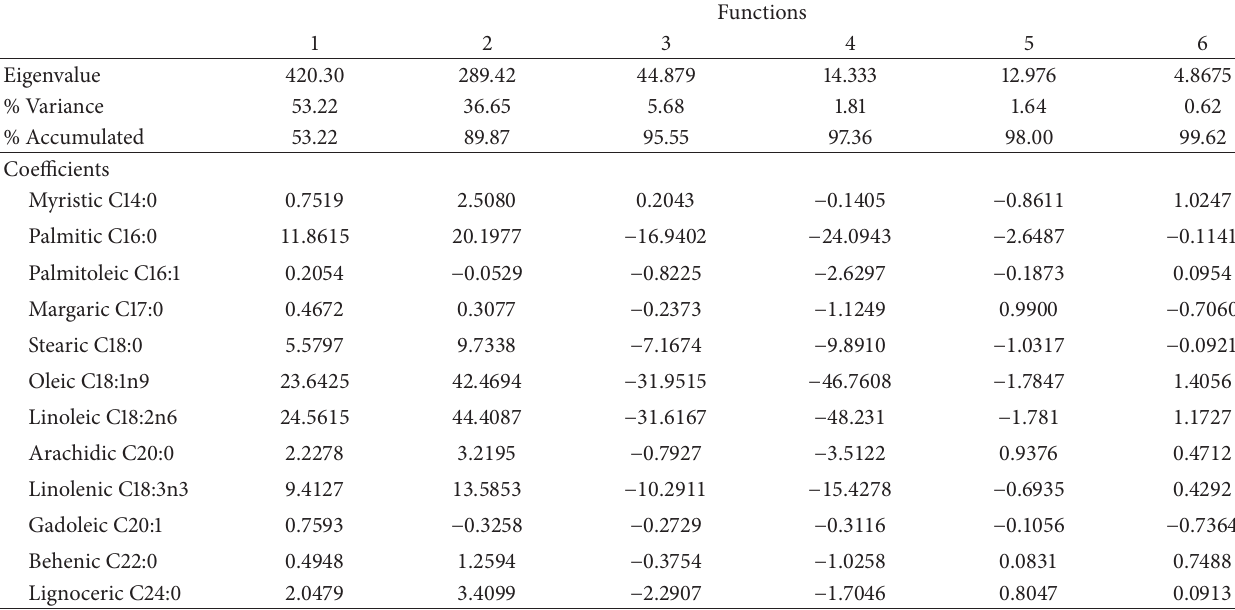
Table 5: Eigenvalues and standardized coefficients of the discriminant functions from the discriminant analysis a